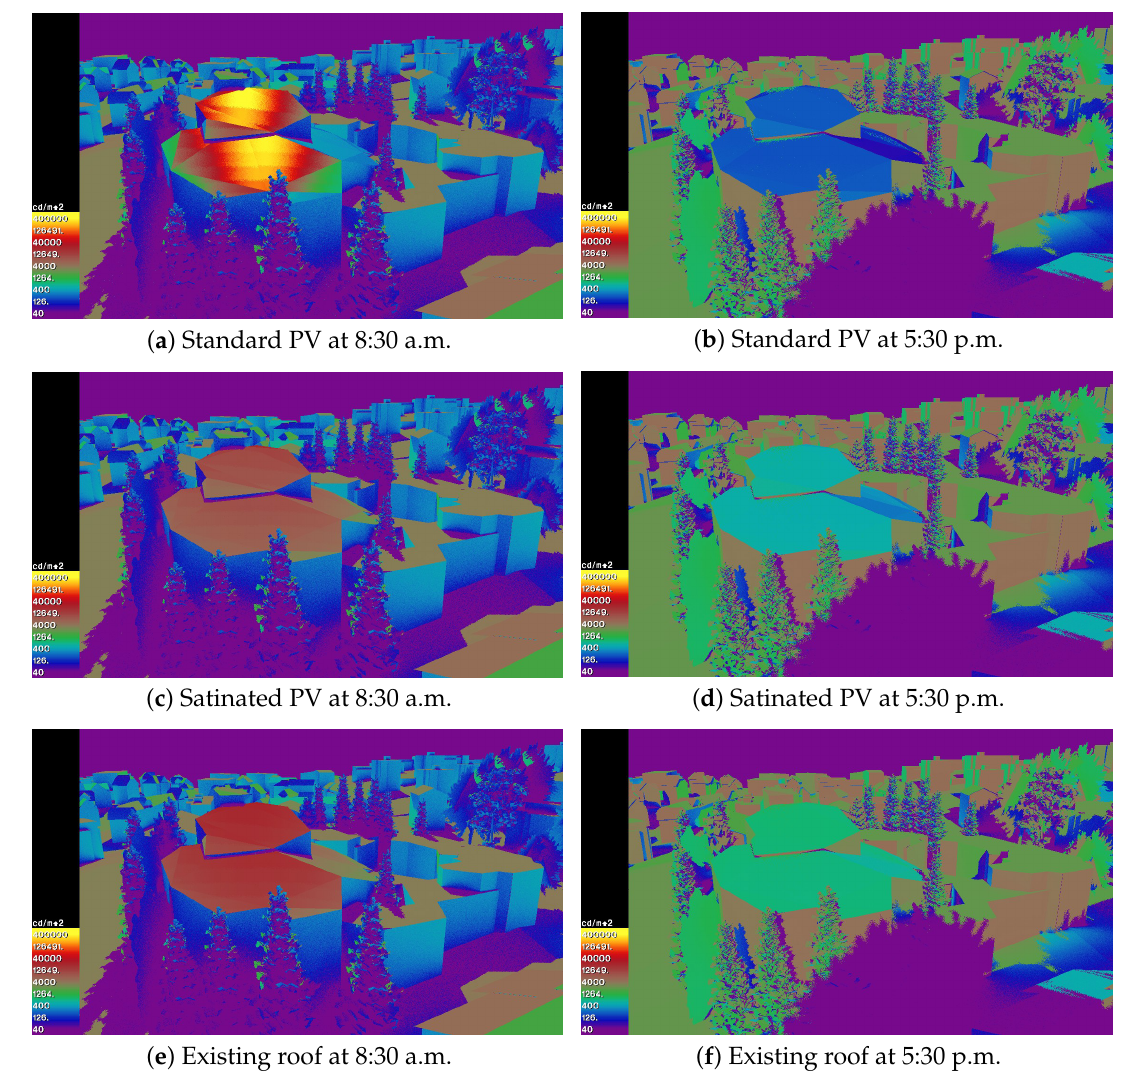
( e ) Existing roof at 8:30 a.m. ( f ) Existing roof at 5:30 p.m. Figure 9. Falsecolour luminance renderings of the case study model looking east on June 11th at 8:30 a.m. ( a , c , e ) and 5:30 p.m. ( b , d , f ). The roof material is modelled as a data-driven BSDF for the standard PV ( a , b ), satinated PV ( c , d ), and existing roof tile ( e , f ). The distinct scattering behaviour of each BSDF is evident at different times of